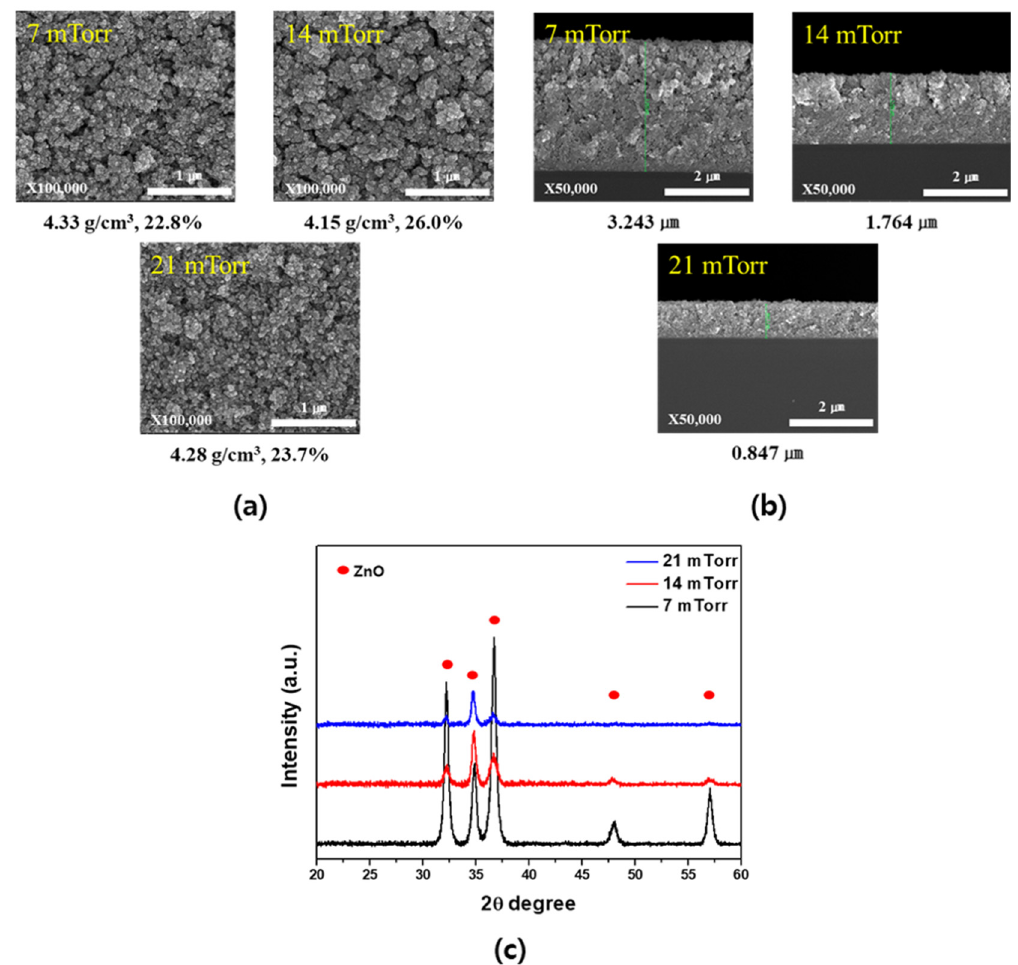
Figure 8. ( a ) Surface SEM images (corresponding densities and porosities indicated below the images), ( b ) cross-section SEM images (corresponding thicknesses indicated below the images), and ( c ) XRD patterns following the wet post-oxidation process at various deposition pressures.